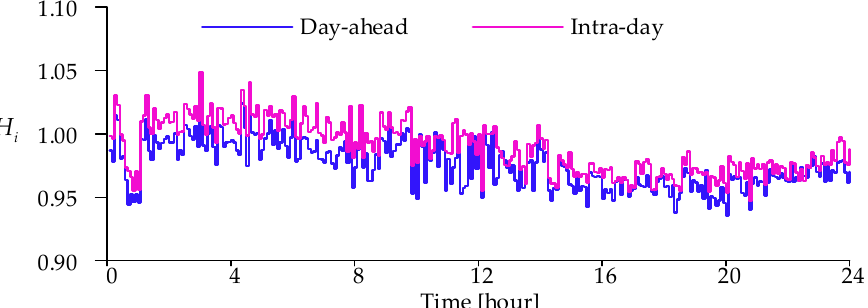
Figure 11. Comparison of real H values before and after intra-day adjustment under cloudy sky conditions.